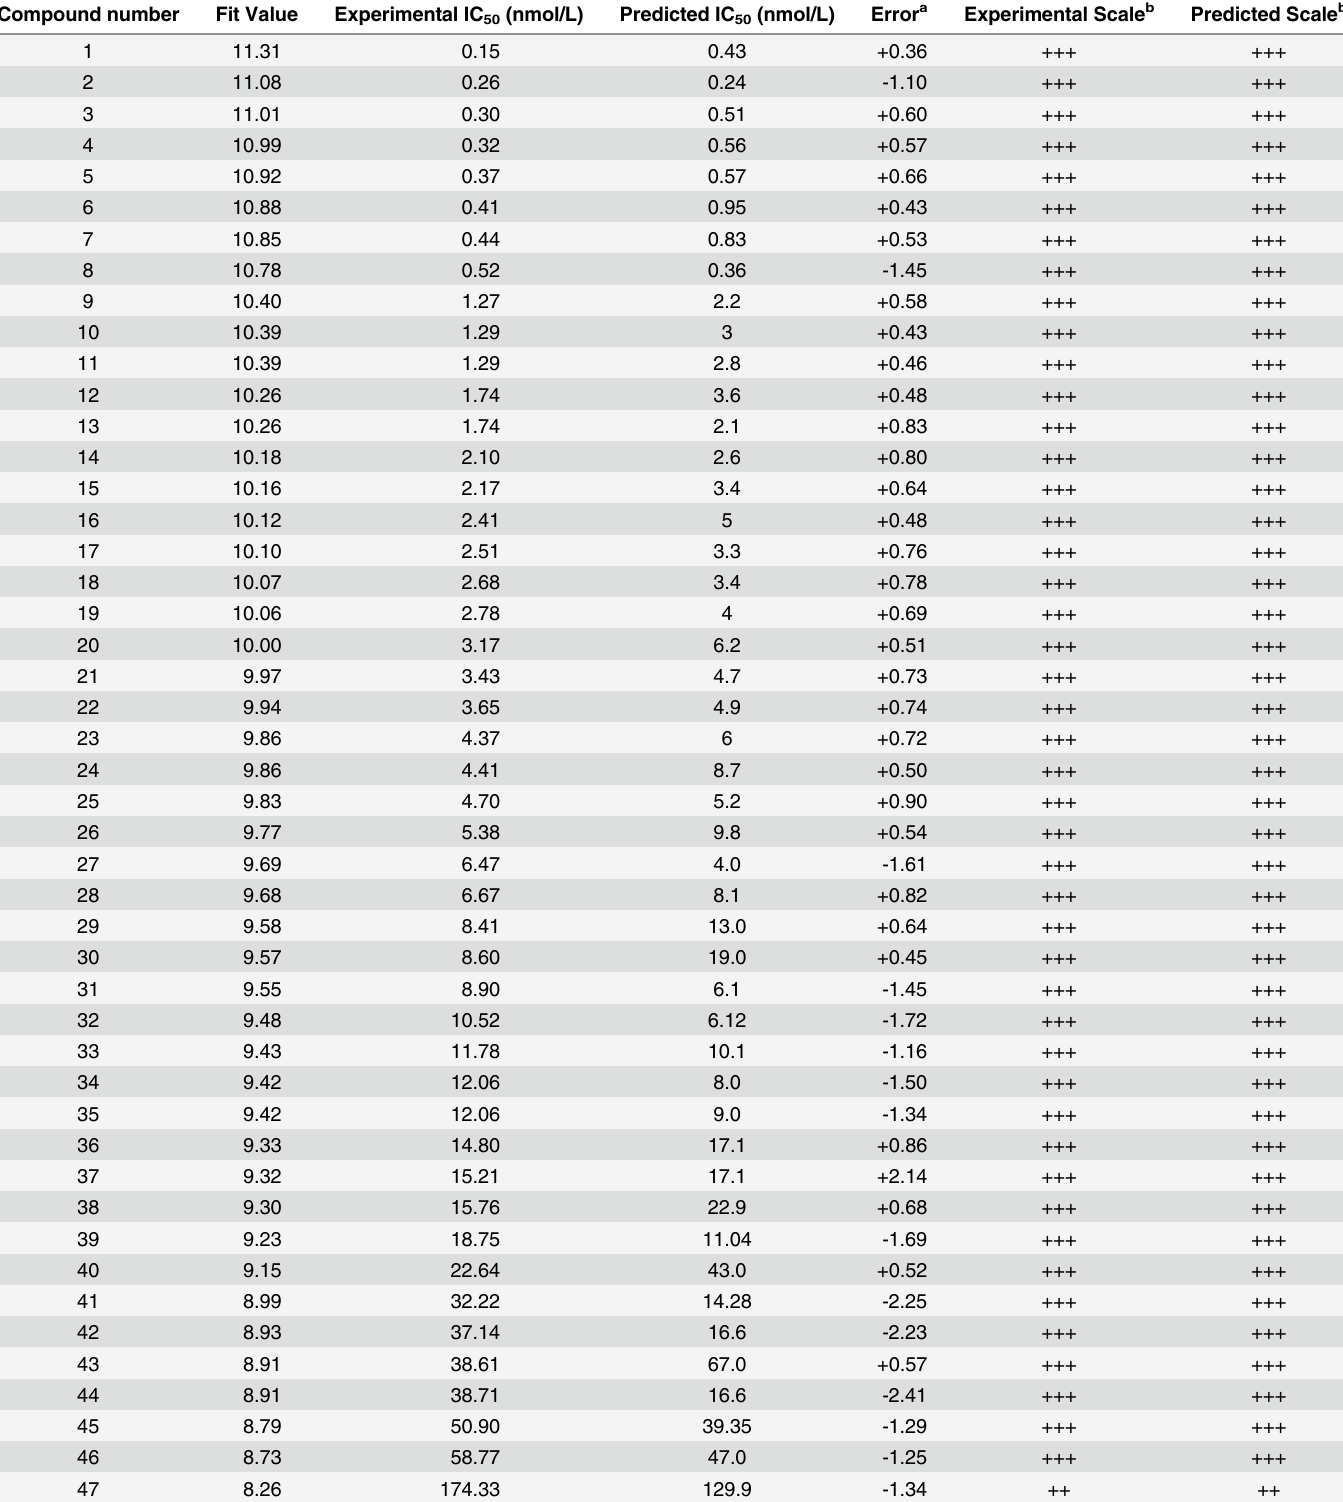
Table 3. Evaluation of estimated and experimental activity (IC 50 ) values of test set compounds using Hypo